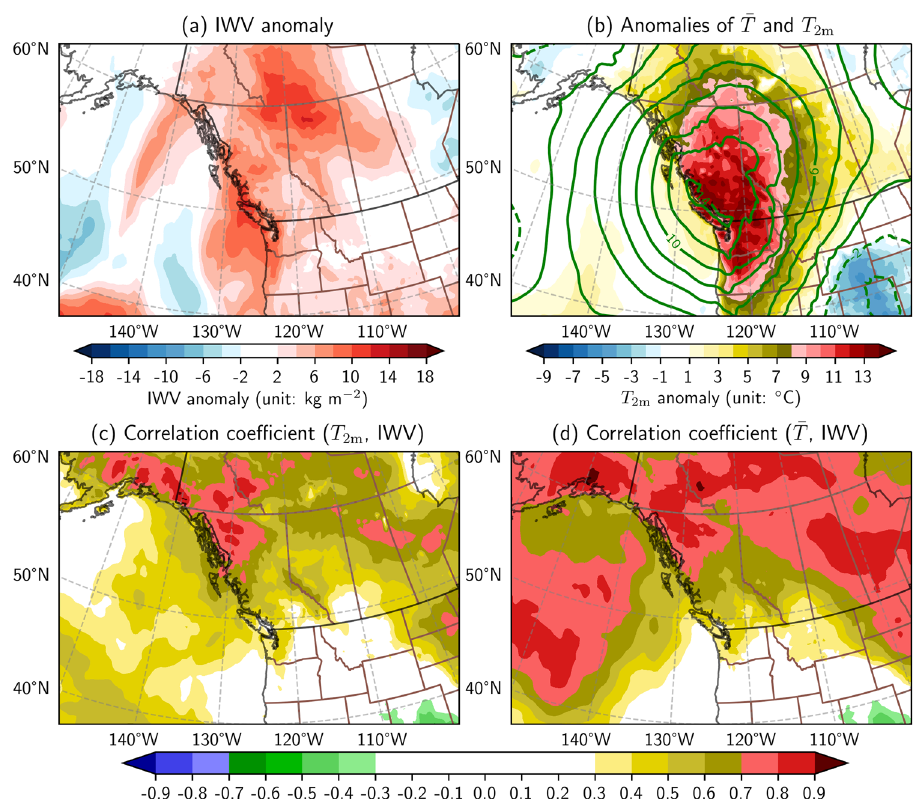
Fig. 7 The anomalies of 5-day (26 – 30 June 2021) mean IWV and air temperatures, together with the correlation coef fi cients between them. All data are from the ERA5 reanalysis. The anomalies are calculated based on the 30-year (26 – 30 June, 1991 – 2020) climatology. In a , the IWV anomalies over western Canada can be attributed to the water vapour transport from the oriental express. In b , the lower-tropospheric averaged temperature ( (cid:1) T ) anomalies are represented by line contours with intervals of 2 °C, and the 2 m temperature ( T 2m ) anomalies are colour- fi lled. In c , d , the correlation coef fi cients are calculated from 43-year (1979 – 2021) data; the coef fi cient values between − 0.30 and 0.30 are statistically insigni fi cant with p -values beyond 0.05 based on the two-tailed Student